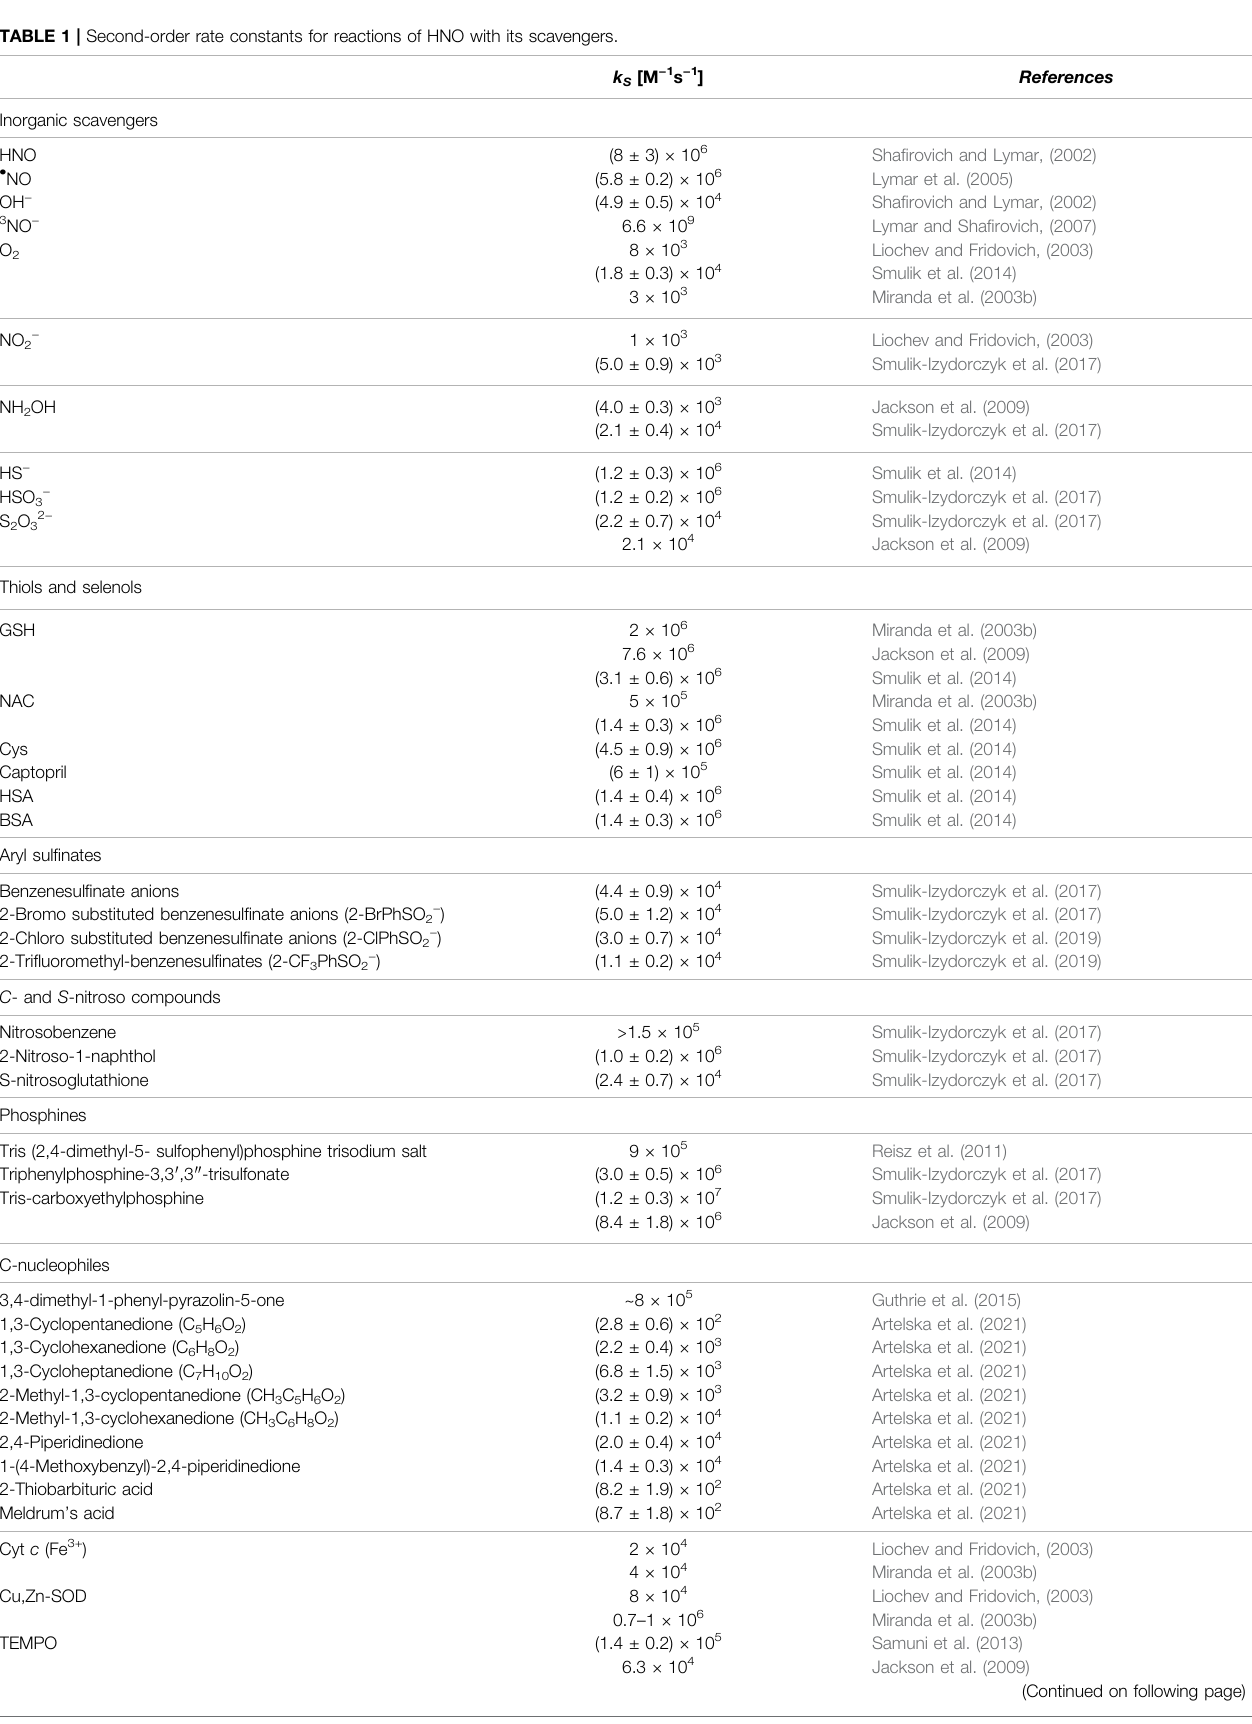
TABLE 1 | Second-order rate constants for reactions of HNO with its